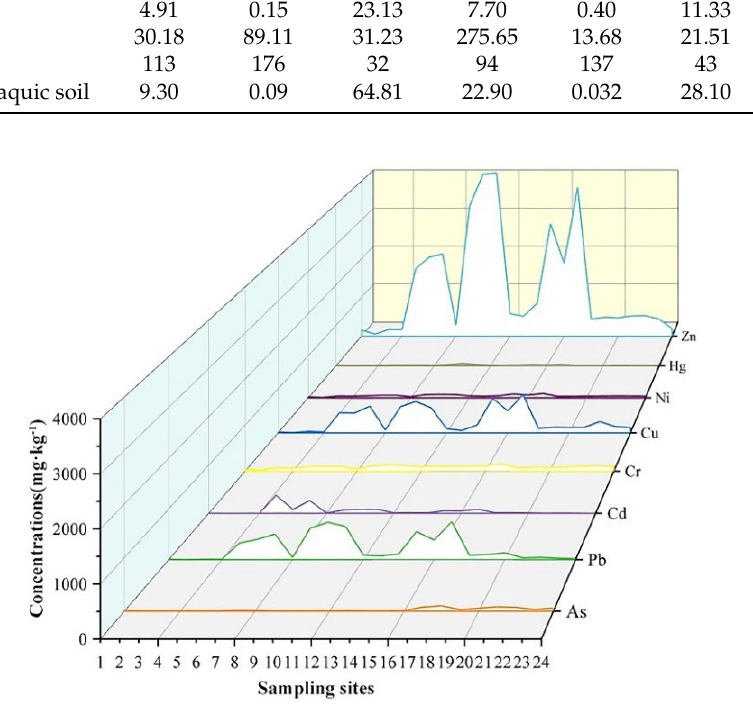
Figure 2. The concentrations of heavy metals in the sediments from the Huafei River. The coefficients of variation (CV) of Cd, Hg, As, Pb, Zn and Cu were high, measuring 176%, 137%, 113%, 110%, 104% and 94%, respectively (Table 3), indicating that the spatial dif- ferences of heavy metal concentrations in the river sediment are large, and the accumulation of these heavy metals in river sediment has been significantly affected by human activities.